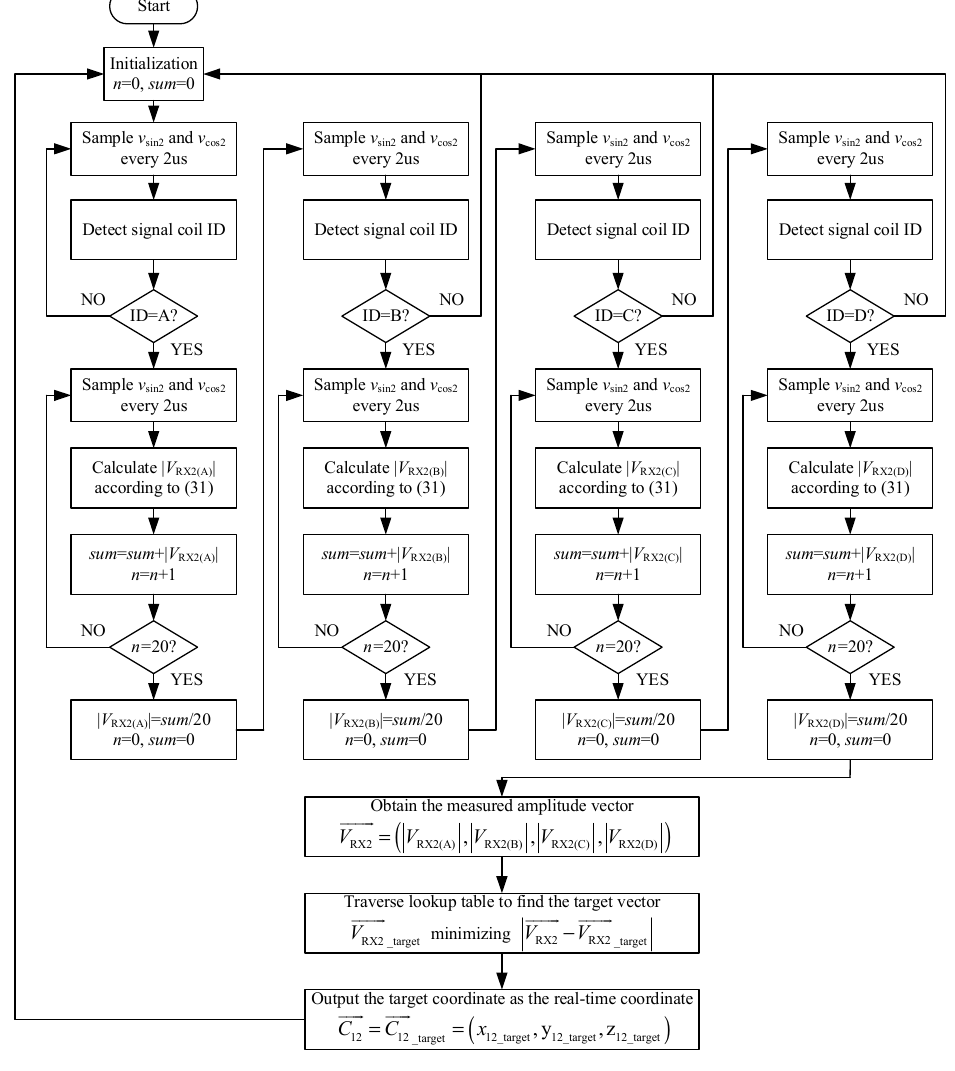
Figure 11. Procedure for deriving 3D position coordinate.